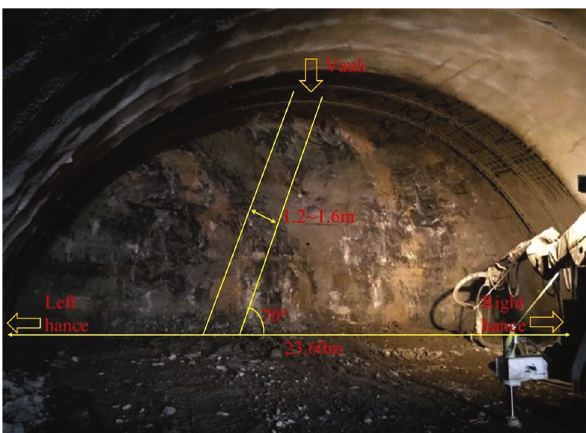
Figure 10: Typical study cross-section.